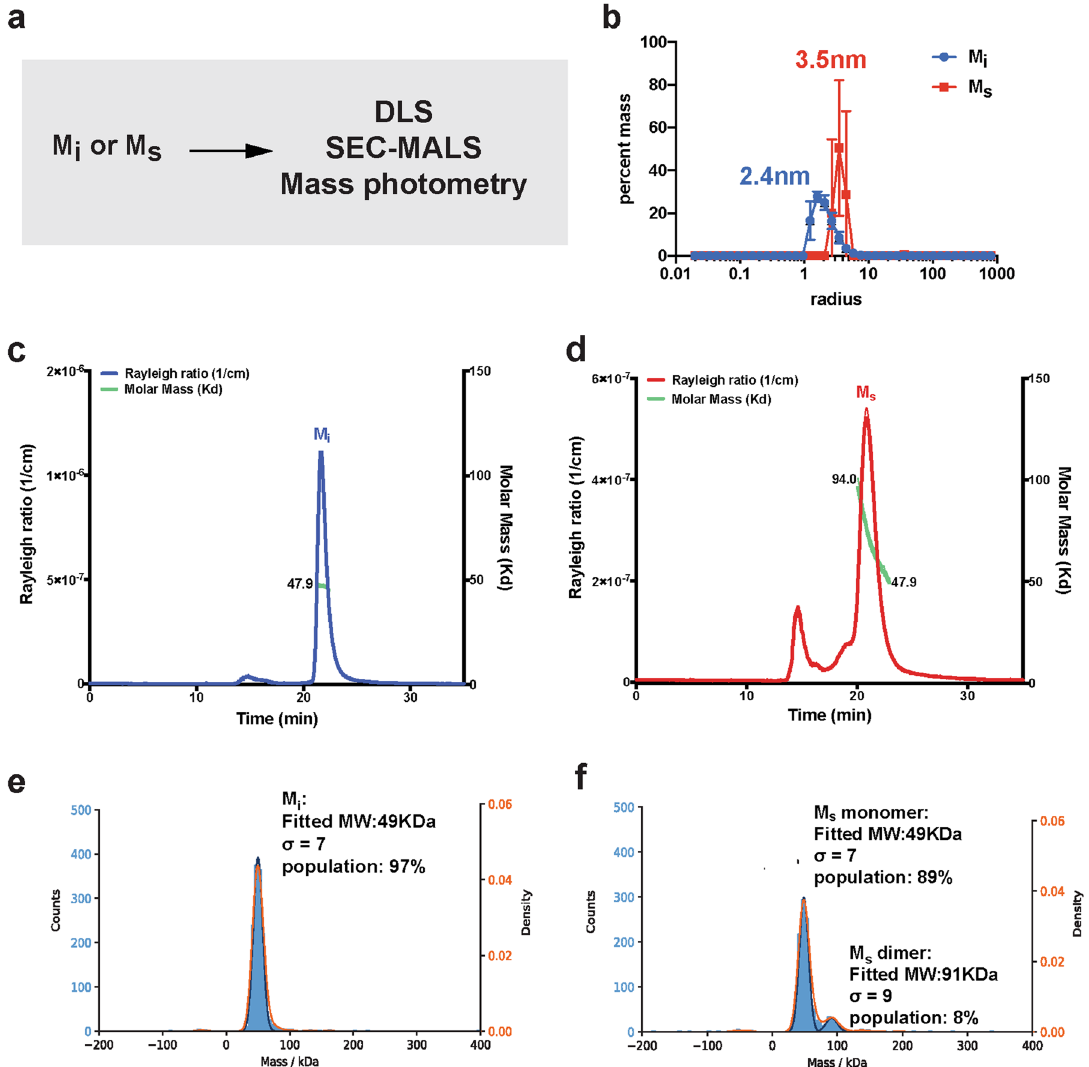
Figure 2. Quantification of tau seed shape and mass. ( a ) Schematic for experiments to measure the size of M i and M s using DLS, SEC-MALS and mass photometry. ( b ) Histogram of sizes observed for 4uM M i (blue) and 4uM M s (red) in DLS. ( c ) SEC-MALS of 16uM M i (blue) shows a single peak that was calculated to have a molar mass of 47.9 g/mol (green). The single peak indicates that M i tau elutes as a monomer. ( d ) SEC-MALS of 16uM M s (red) shows a broader peak that was calculated to range from 94 g/mol to 47.9 g/mol (green). The broader peak indicates that M s tau elutes as a distribution of dimer and monomer with minor signal from oligomers. ( e ) Mass photometry measurements of 50 nM M i reveals the sample to be uniformly monomeric with a calculated molecular weight of 49 kDa accounting for 97% of the sample with a sigma of 7. ( f ) Mass photometry measurements of 50 nM